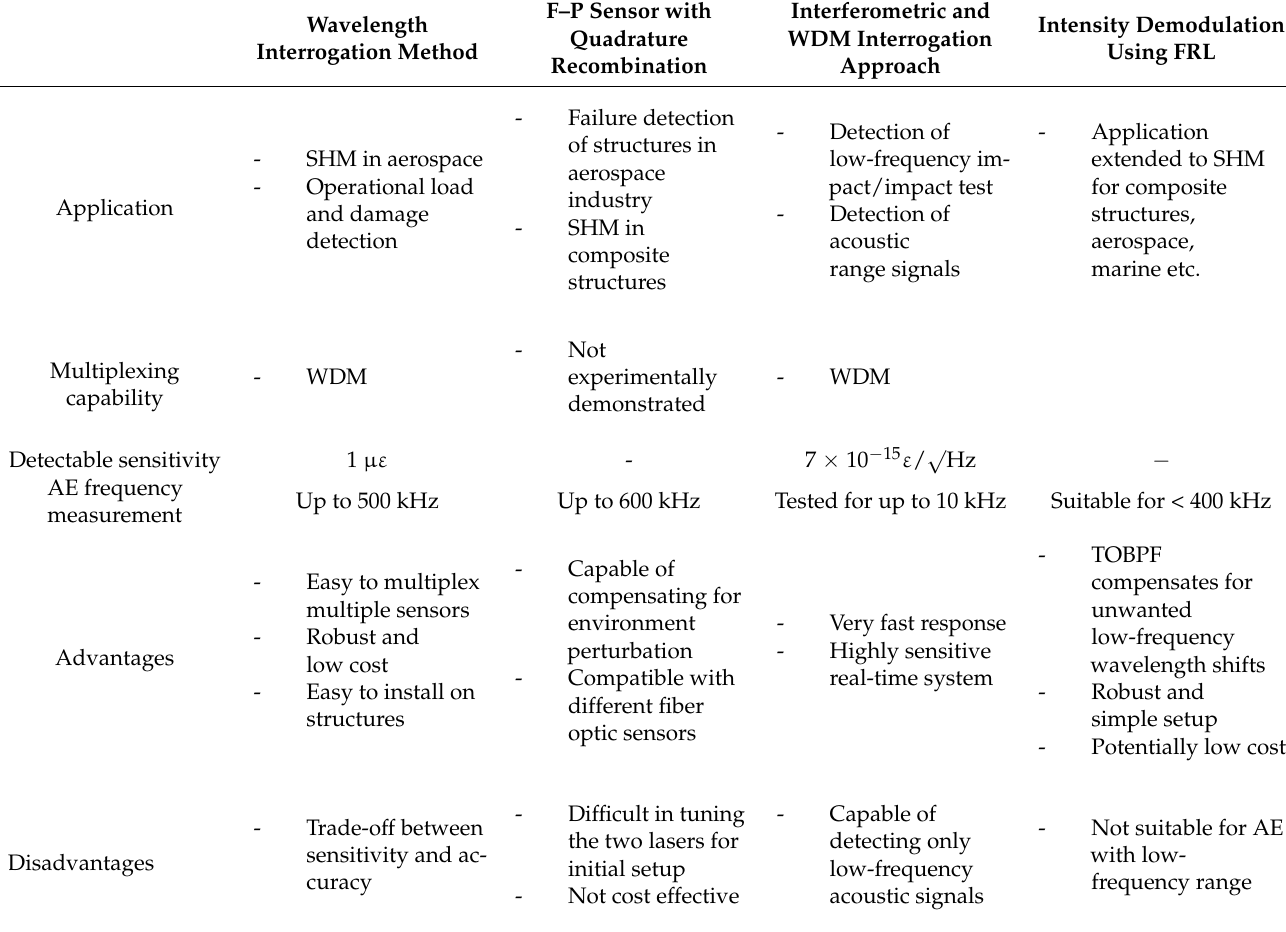
Table 3. Comparison between proposed FBG AE interrogation techniques